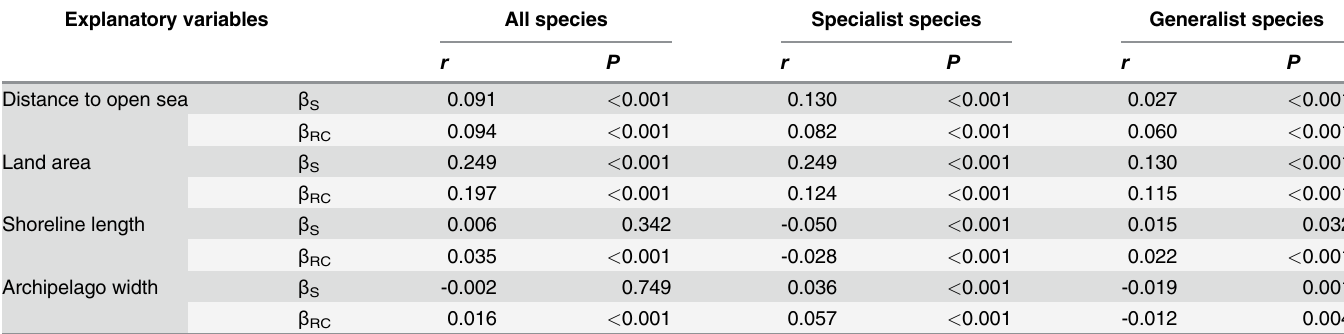
r values, estimated by partial Mantel tests, are the correlations of S ø rensen ’ s dissimilarity index ( β S ) or the probabilistic Raup-Crick measure ( β RC ), respectively, with the distance matrices for the explanatory variables. P indicates statistical signi fi cance. Communities were de fi ned as All species, Specialist species (i.e. bird species breeding only in the archipelago) or Generalist species (i.e. bird species breeding in the archipelago but also in inland